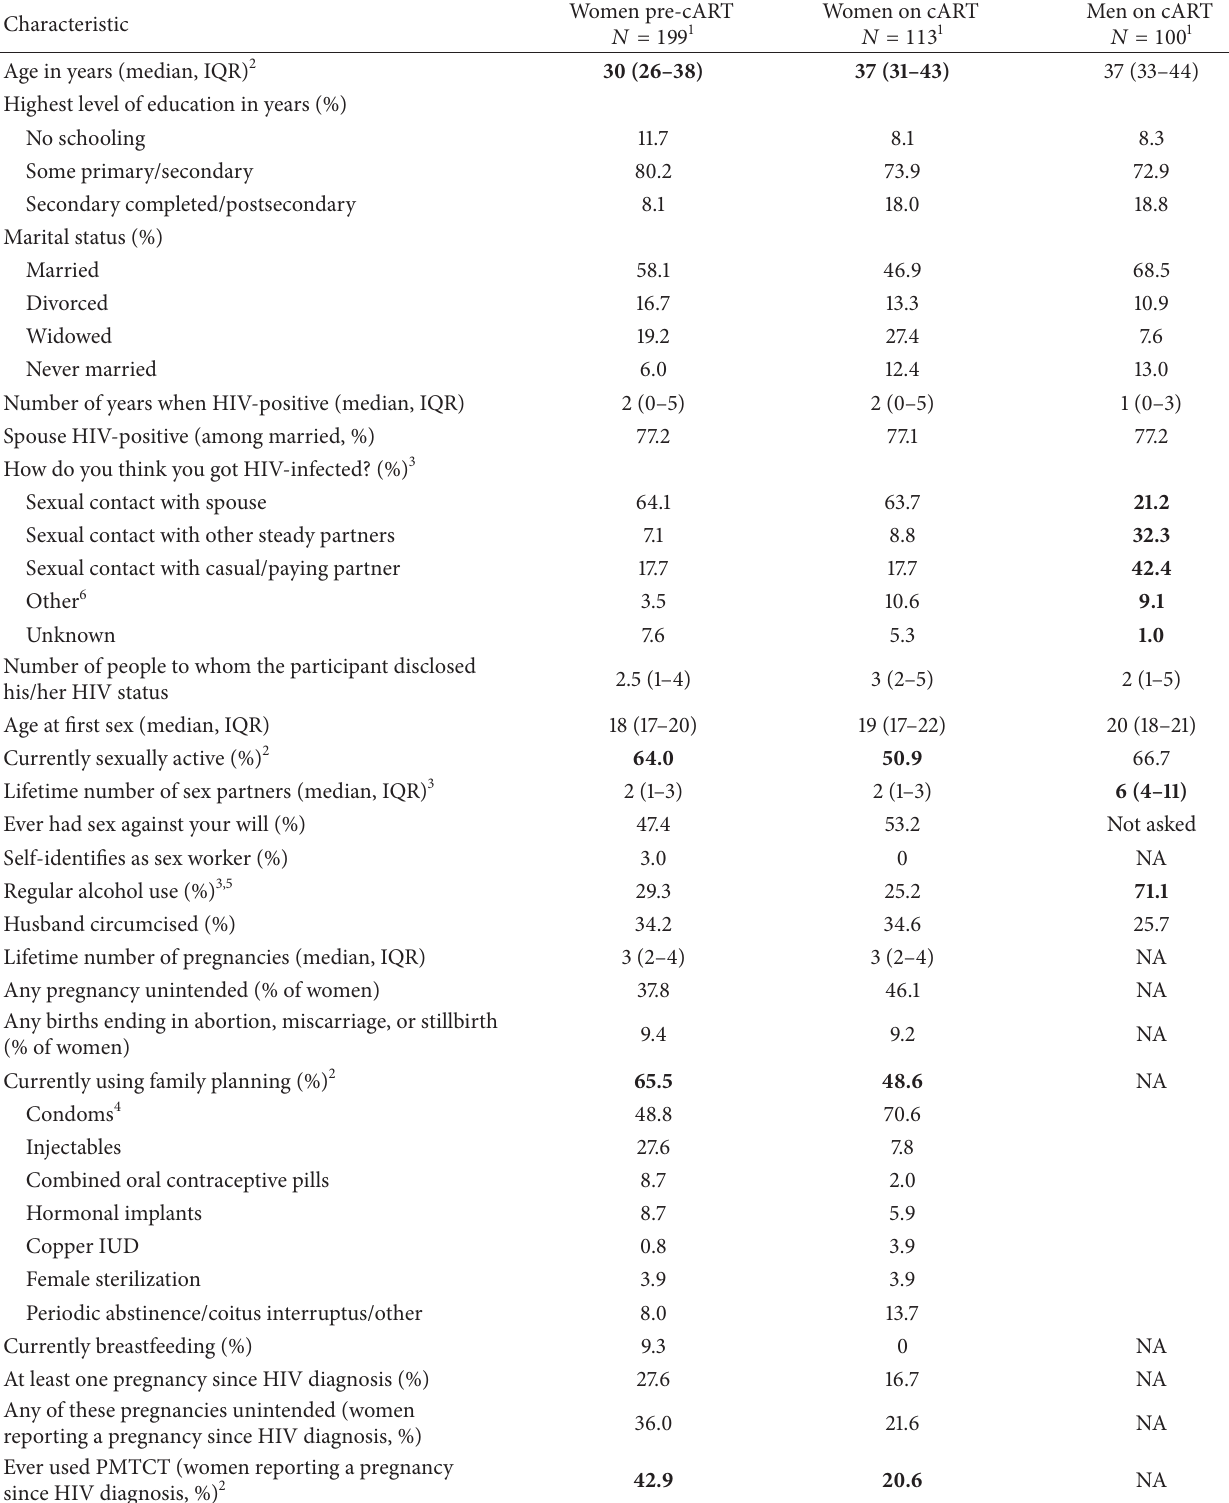
Table 1: Baseline sociodemographic, sexual, and reproductive